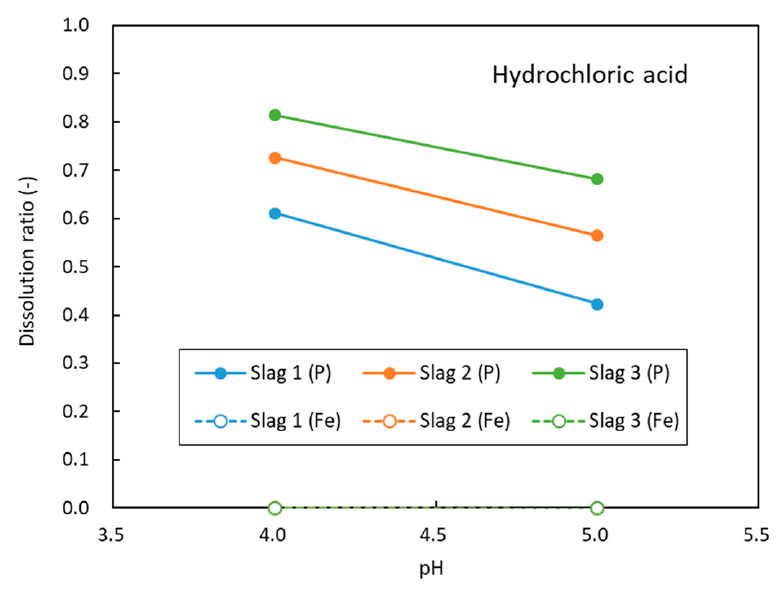
Figure 4. Dissolution ratio of each element from dephosphorization slag in hydrochloric acid solution at various pH conditions.